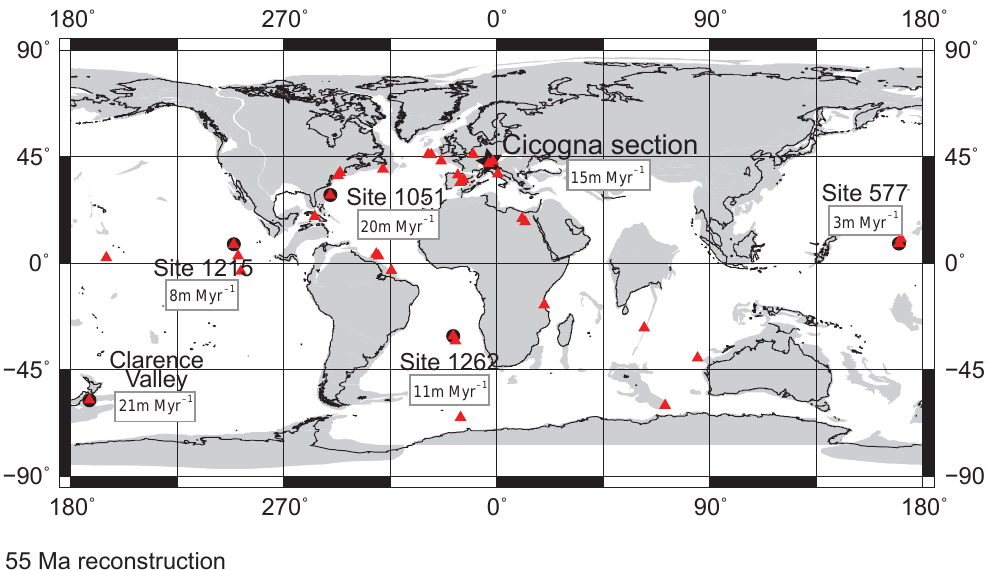
Figure 2. Paleogeographic map indicating approximate locations at 55Ma for several key sites with detailed stable isotope records across the late Paleocene and early Eocene. These include (marked with black dots and star) the Cicogna section (NE Italy, this study), DSDP Site 577 (Shatsky Rise; Dickens and Backman, 2013), ODP sites 1051 (Blake Nose, Ogg and Bardot, 2001), 1215 (central Pacific; Raffi et al., 2005), and 1262 (Walvis Ridge; Westerhold et al., 2008), and the Clarence Valley (CV) sections (New Zealand; Slotnick et al., 2015b). The gray areas represent plate fragments, while the black lines show present-day shorelines. Boxes next to site locations show average sedimentation rates from the base of Chron C25n to the base of Chron C23r (57.20–52.36Ma). The base map is from http://www.odsn.de/ odsn/services/paleomap/paleomap.html. Red triangles are locations where a decrease in diversity of Fasciculithus spp. has been documented near the PETM. Locations include the Clarence Valley sections, central Pacific (ODP sites 1215, 1220, 1221), western Pacific (DSDP Site 577 and ODP Site 865), South Atlantic (Walvis Ridge, DSDP Site 527, ODP sites 1262, 1263–1267; Maud Rise, ODP Site 690), equatorial Atlantic (Ceara Rise, ODP Site 929, Demerara Rise, ODP sites 1259, 1260), northwestern Atlantic (New Jersey Margin land sections, ODP Site 1051, IODP Site U1403, U1409), northeastern Atlantic (Bay of Biscay DSDP sites 401, 549 and 550, Zumaya land section), and Indian Ocean (DSDP Site 213; ODP 672; Kerguelen Plateau, ODP Site 1135; Backman, 1986; Aubry, 1999a; Bralower, 2002; Dupuis et al.,